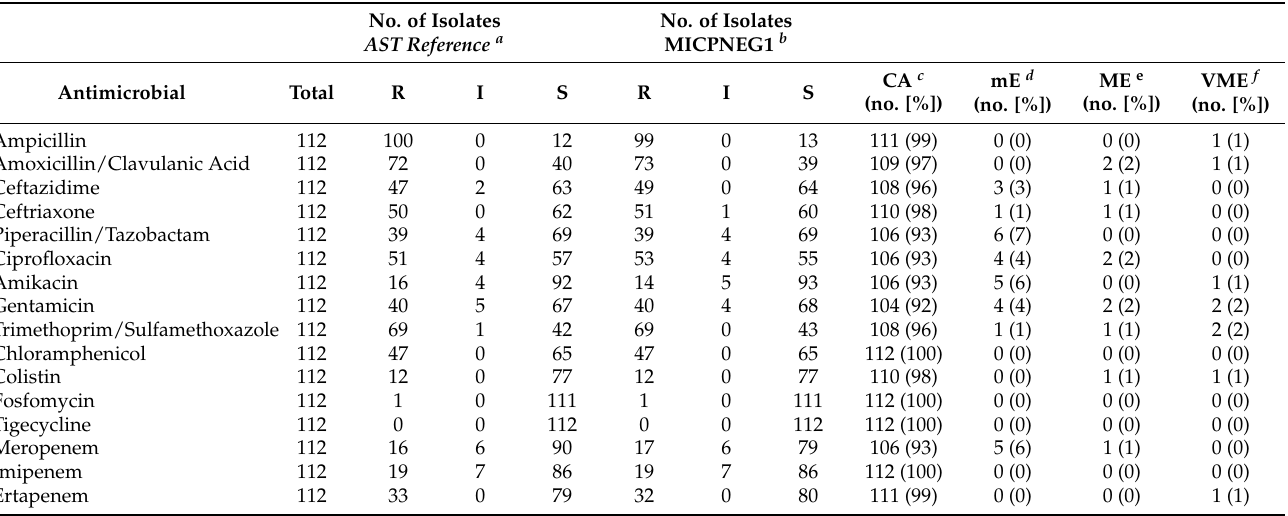
Table 4. Results for Enterobacterales tested with the MICNEG1 standard turbidity inoculum method and visual reading versus AST reference